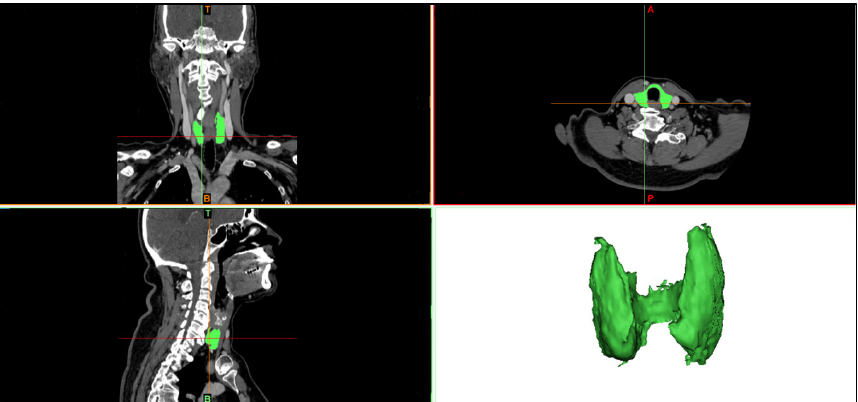
Figure 14. Illustration of a set of CT images visualized in the MIMICS software, to allow for the segmentation and 3D reconstruction of the thyroid geometry in the neck region. segmentation and 3D reconstruction of the thyroid geometry in the neck region.